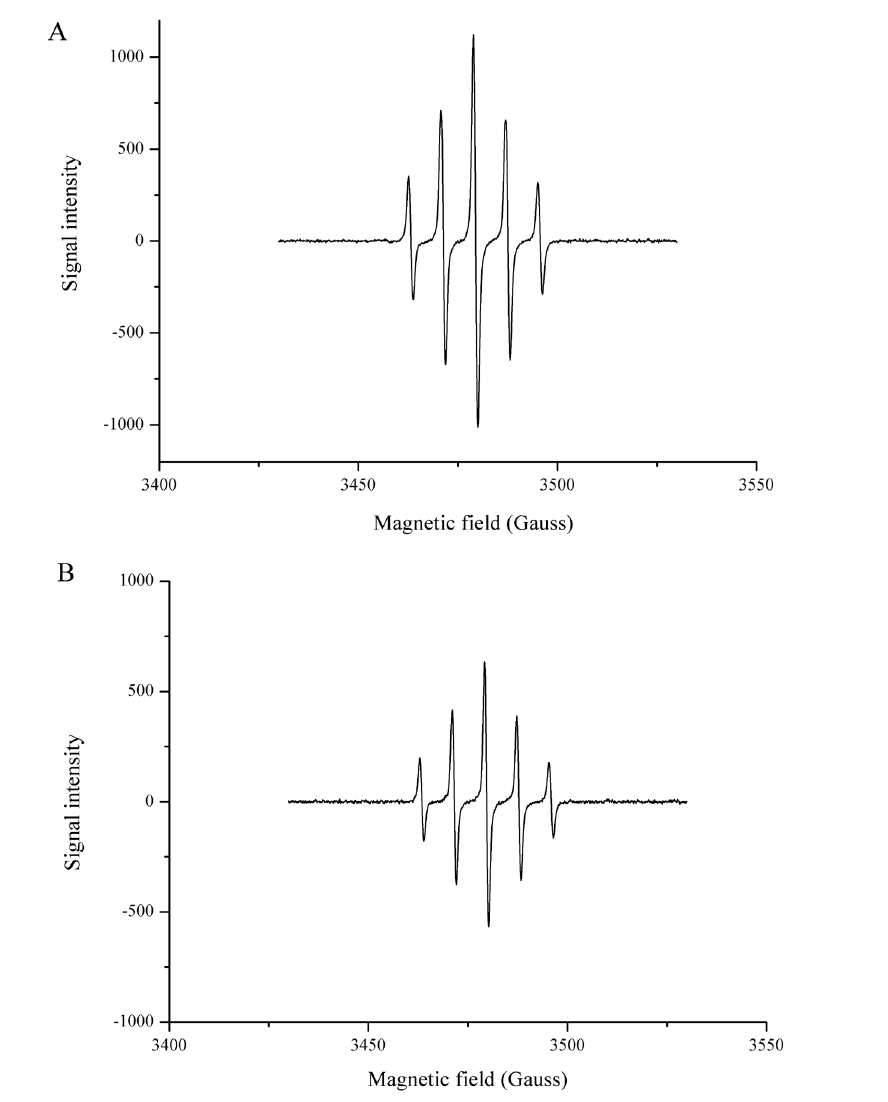
Figure 6. EPR spectra of •PTIO in sodium phosphate buffer (50 mM, pH 7.4) without (A) and with (B) Hsp90. Signal of •PTIO decreased after the addition of 2.5 μM Hsp90. Hsp90, 90 Kda heat shock protein; EPR, electron paramagnetic resonance; PTIO, 2-phenyl-4,4,5,5,-tetramethylimidazo -